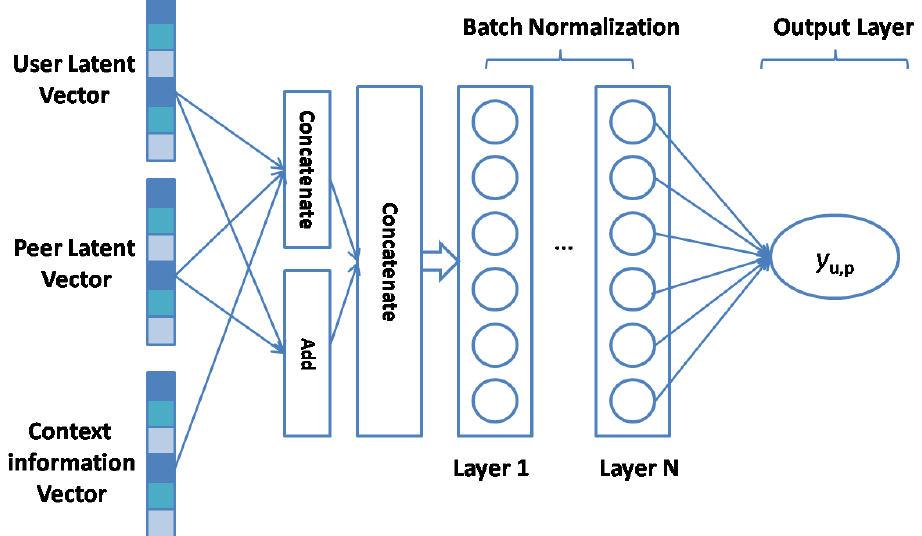
Figure 4. The Neural Fusion Collaborative